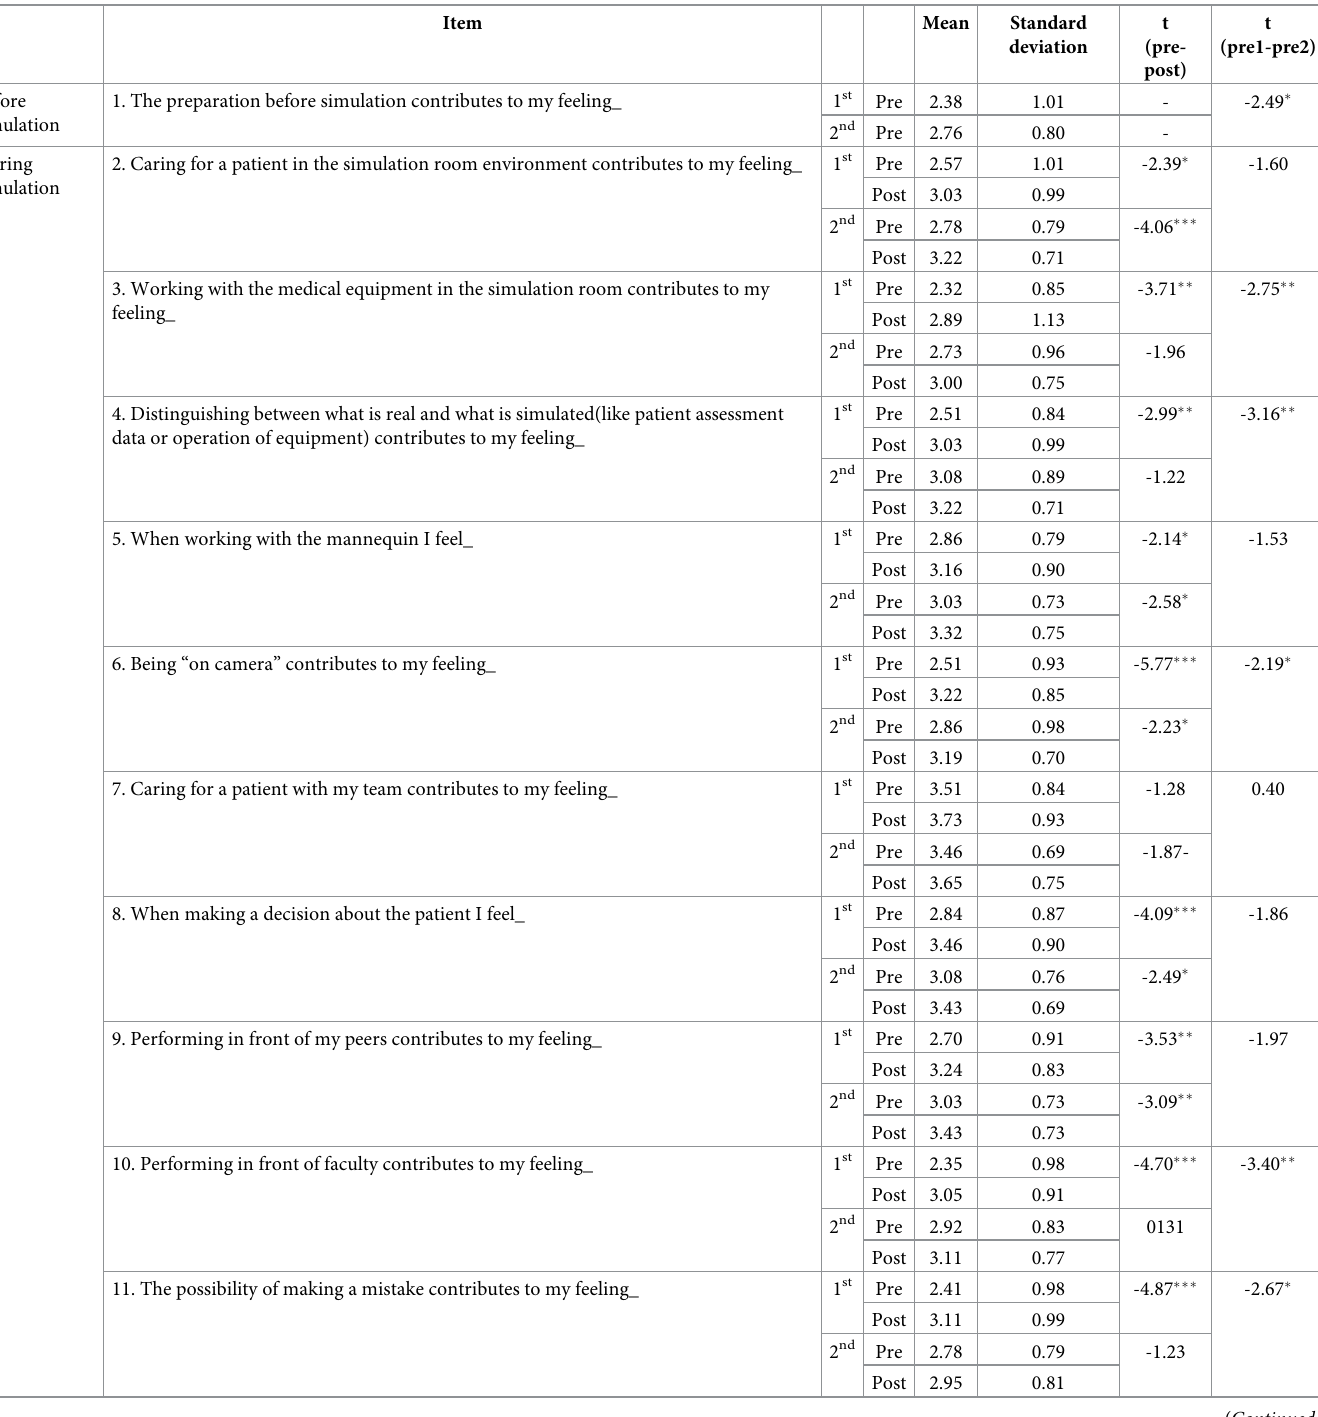
Table 2. Comparison of changes in confidence level according to simulation practice.